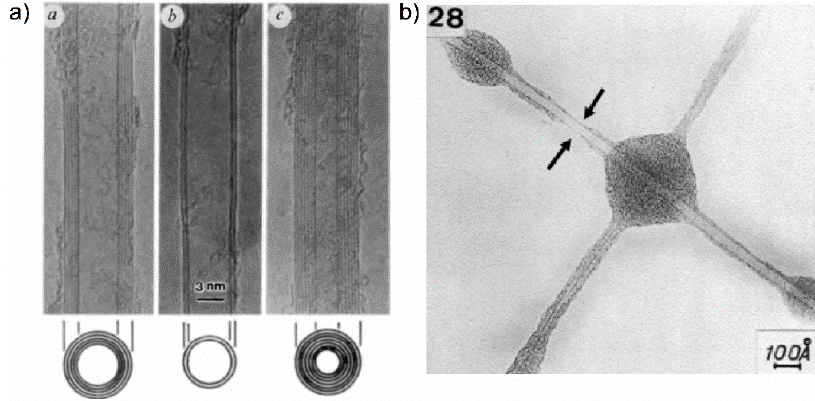
Figure 28. ( a ) First HRTEM images of multiwalled carbon nanotubes published by Iijima in 1991. Reproduced with permission from Iijima [1]. Copyright Springer Nature, 1991. ( b ) TEM image of CNT-like structure published by Oberlin et al. in 1976. Reproduced with permission from Oberlin et al. [100]. Copyright Elsevier, 1976.